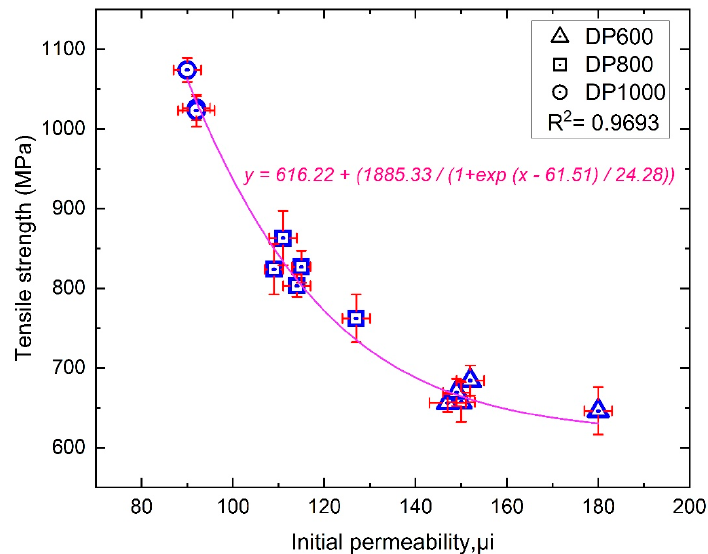
Figure 9. Tensile strength as a function of the initial permeability for the commercial DP600, 800 and 1000 steels.